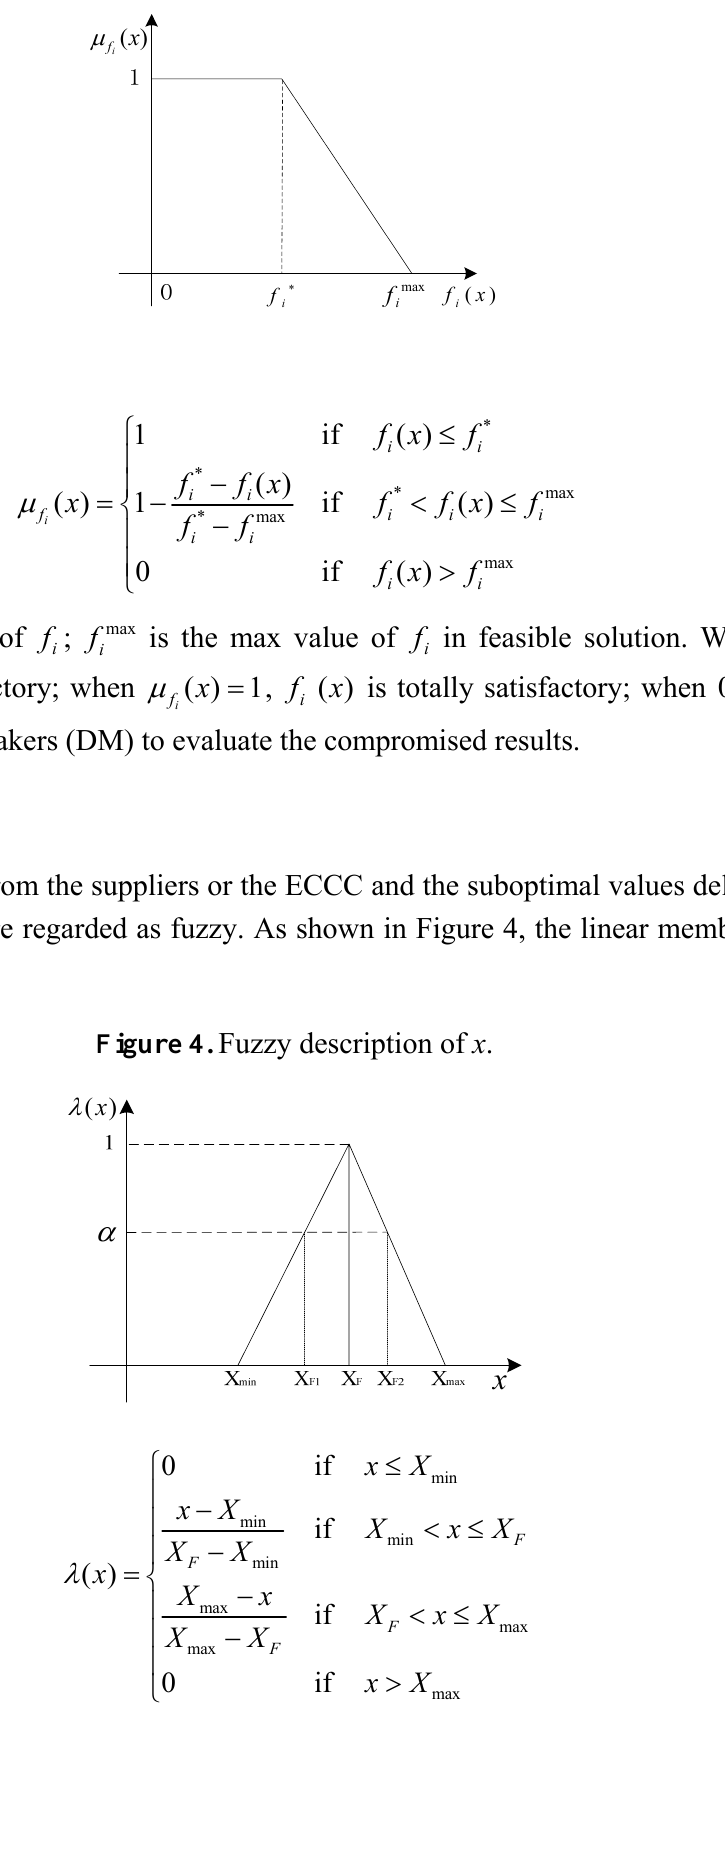
Figure 3. Linear description of the satisfaction degree.